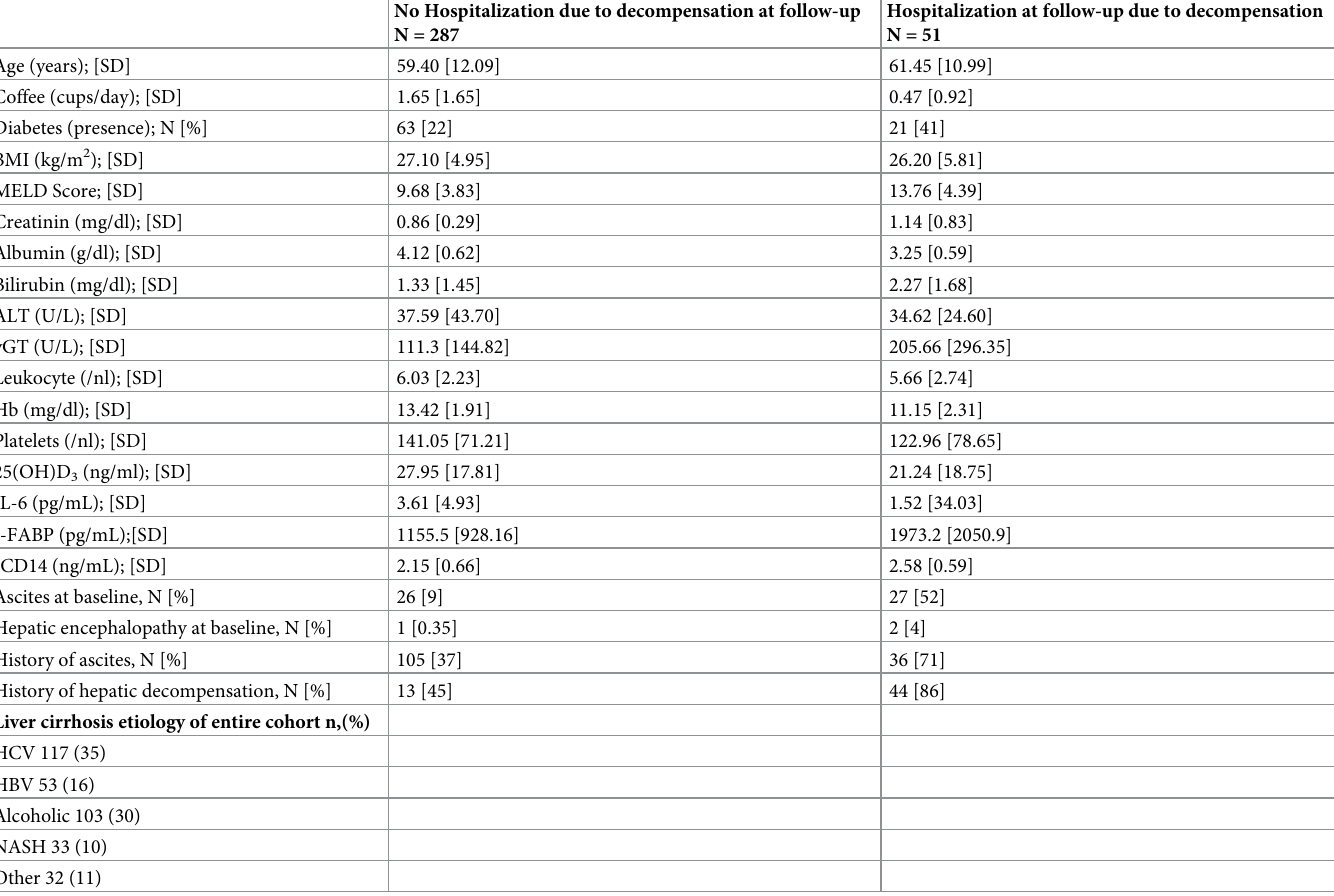
Table 1. Baseline characteristics of included